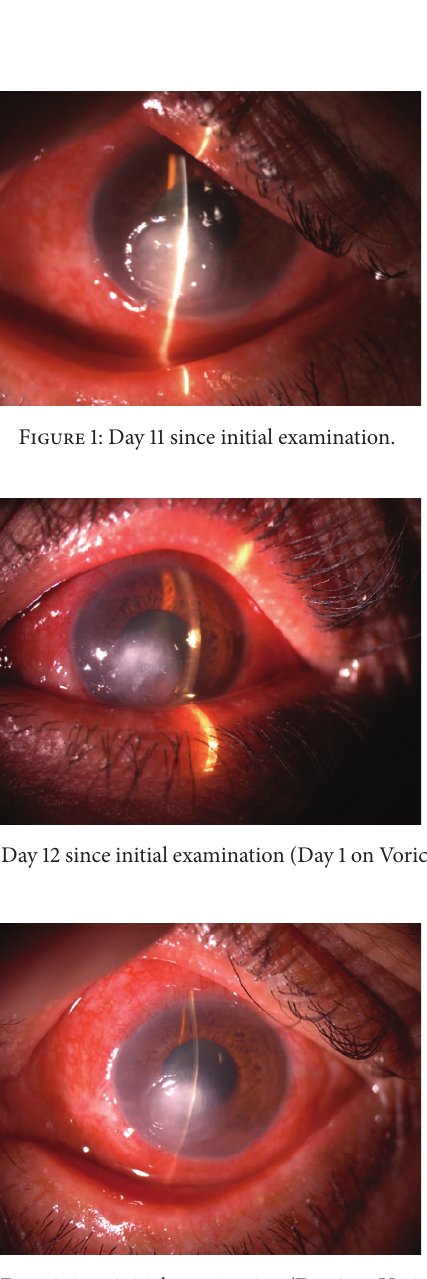
Figure 3: Day 14 since initial examination (Day 3 on Voriconazole).